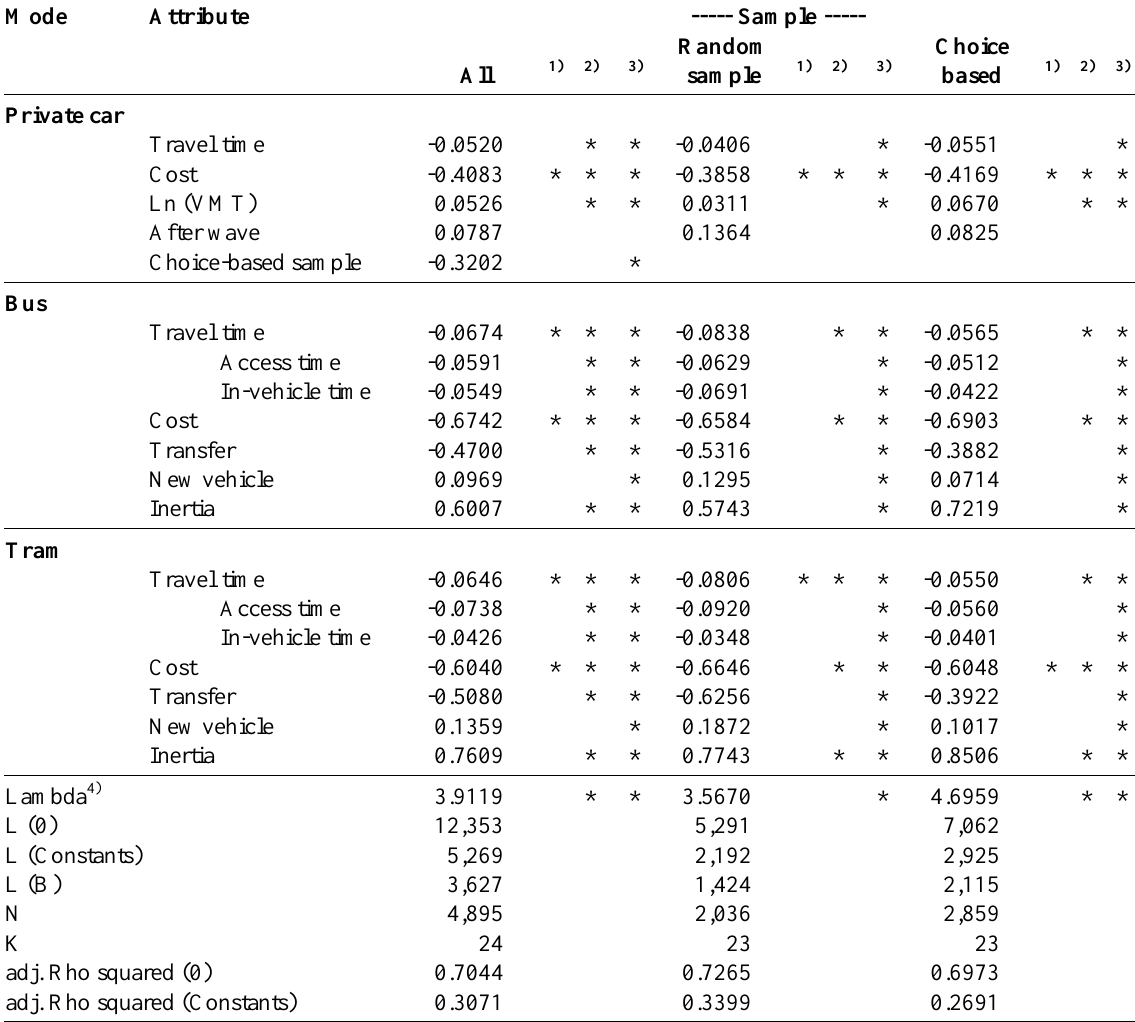
Table 5. Joint SP-experiments: Nested Logit-estimates